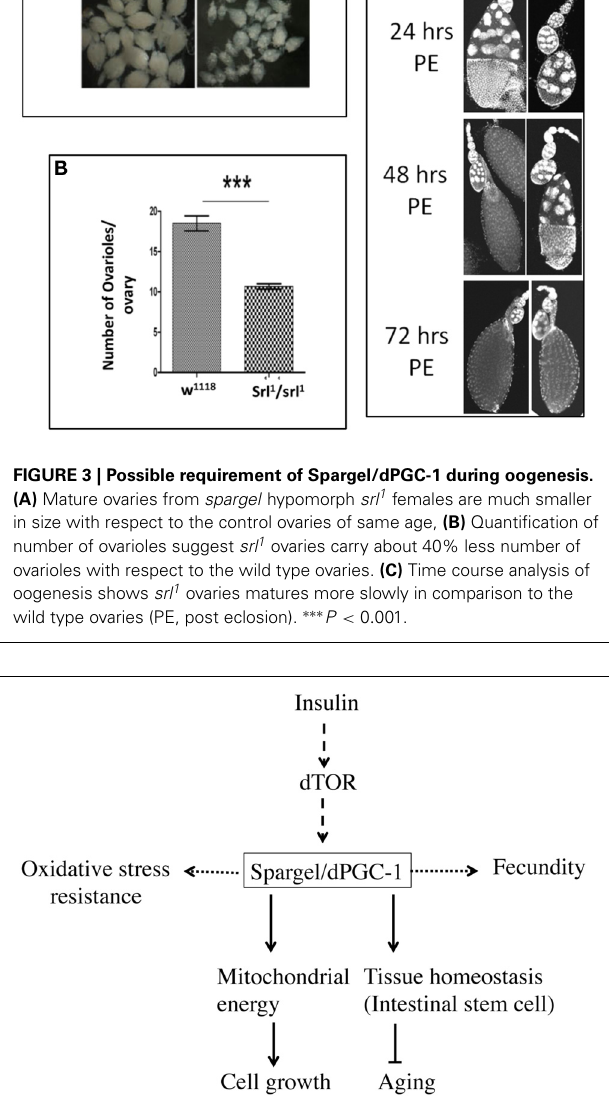
FIGURE 4 | Spargel/dPGC-1 plays a central role in maintaining homeostasis. Spargel/dPGC-1 is acting downstream of Insulin/TOR signaling pathway. At this position, Spargel/dPGC-1 is regulating the mitochondrial energy flow into the system leading to cell growth. In addition, Spargel/dPGC-1 provides oxidative stress resistance. Though unlike mammals, this stress resistance does not confer SOD1 and SOD2 protein expression. Spargel/dPGC-1 also affects Drosophila fecundity possibly through oogenesis. Moreover, Spargel/dPGC-1 regulates tissue homeostasis by controlling over proliferation of intestinal stem cells in older